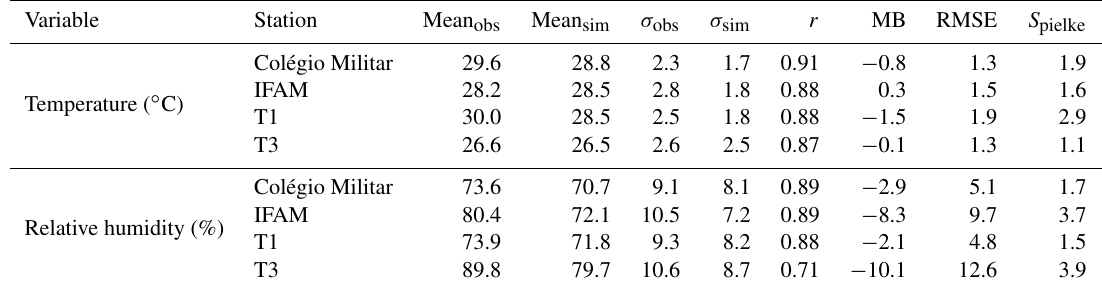
Table 6. Evaluation indexes for model performance of meteorological variables during the simulation period (baseline scenario C0). Variable Station Mean obs Mean sim σ obs σ sim MB RMSE S pielke Colégio Militar Temperature ( ◦ C)